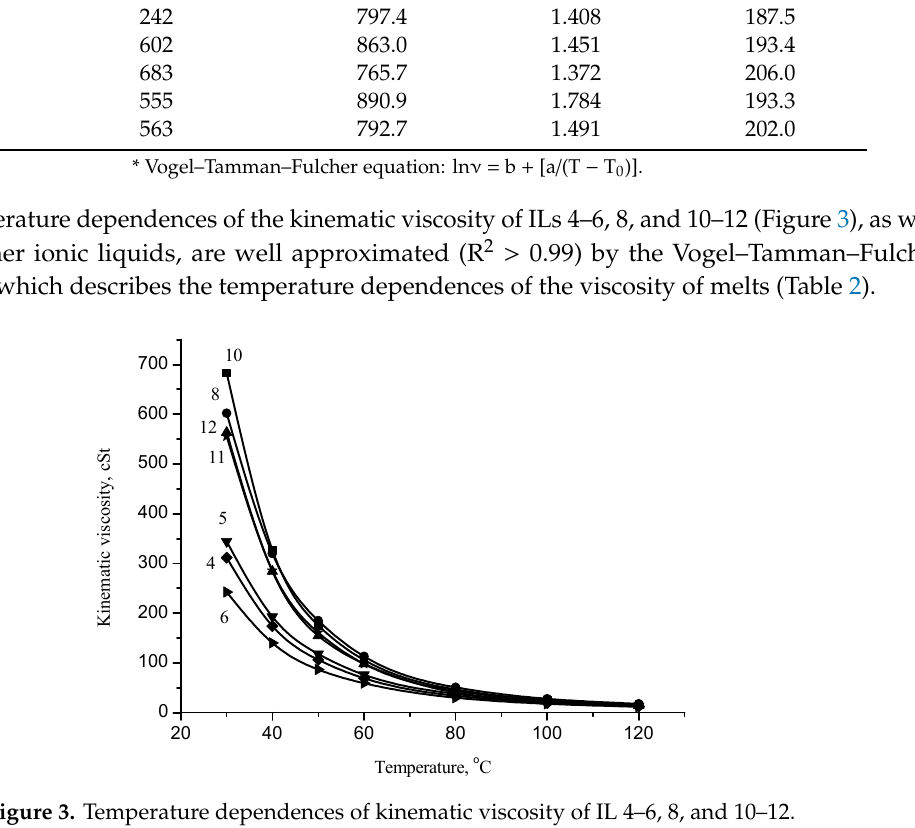
Figure 3. Temperature dependences of kinematic viscosity of IL 4–6, 8, and 10–12.